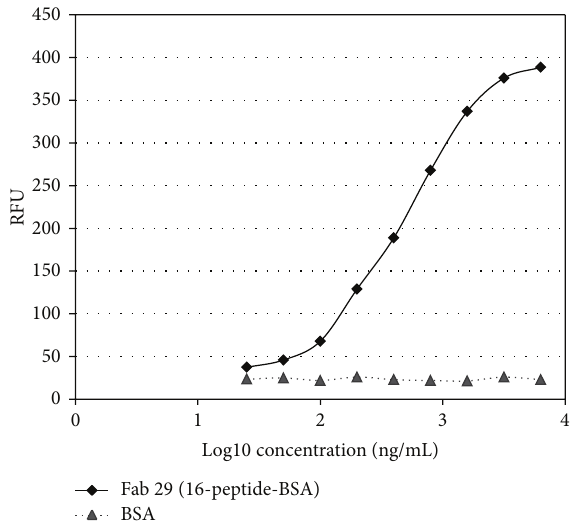
Figure 11: Binding activity assay of anti-P-gp Fab to 16-peptide-BSA and BSA by using indirect